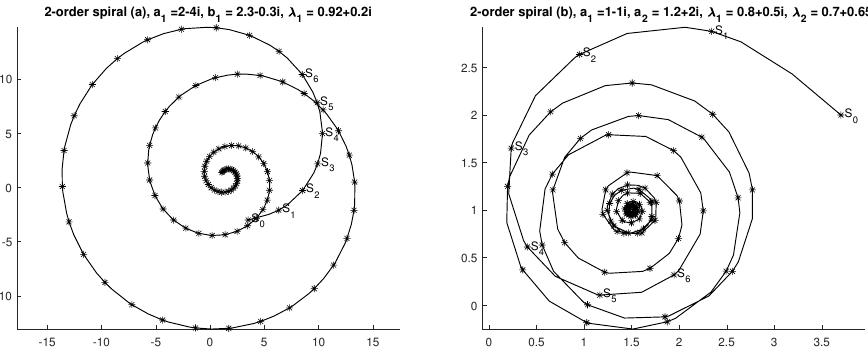
and | λ 2 | < 1. Figure 5 shows the corresponding second order spirals: (a) on the left and (b) on the right.